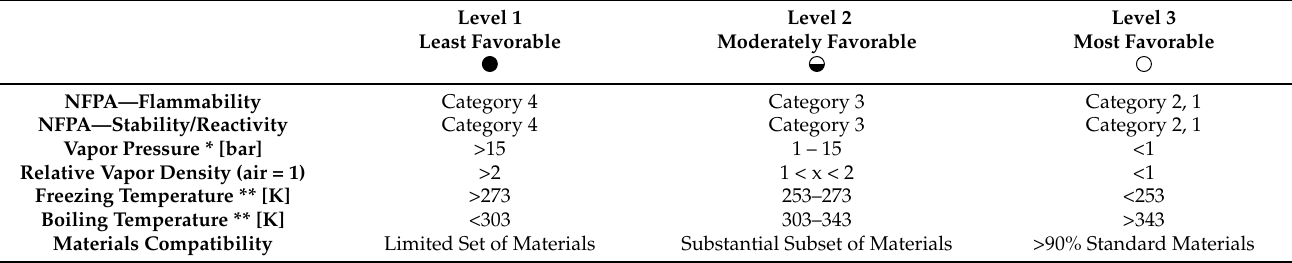
Table 7. Handling and storage rating and prioritization.